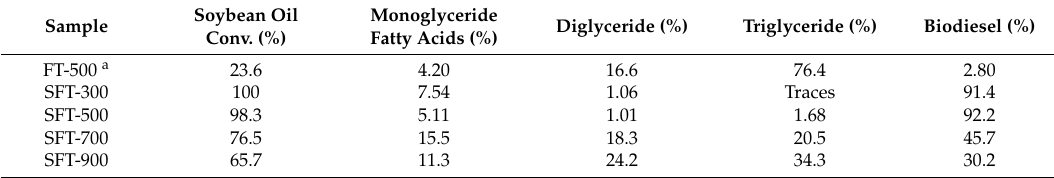
Table 9. Products and yields of reactions with unsulfated and sulfated Fe 2 O 3 /TiO 2 catalyst.